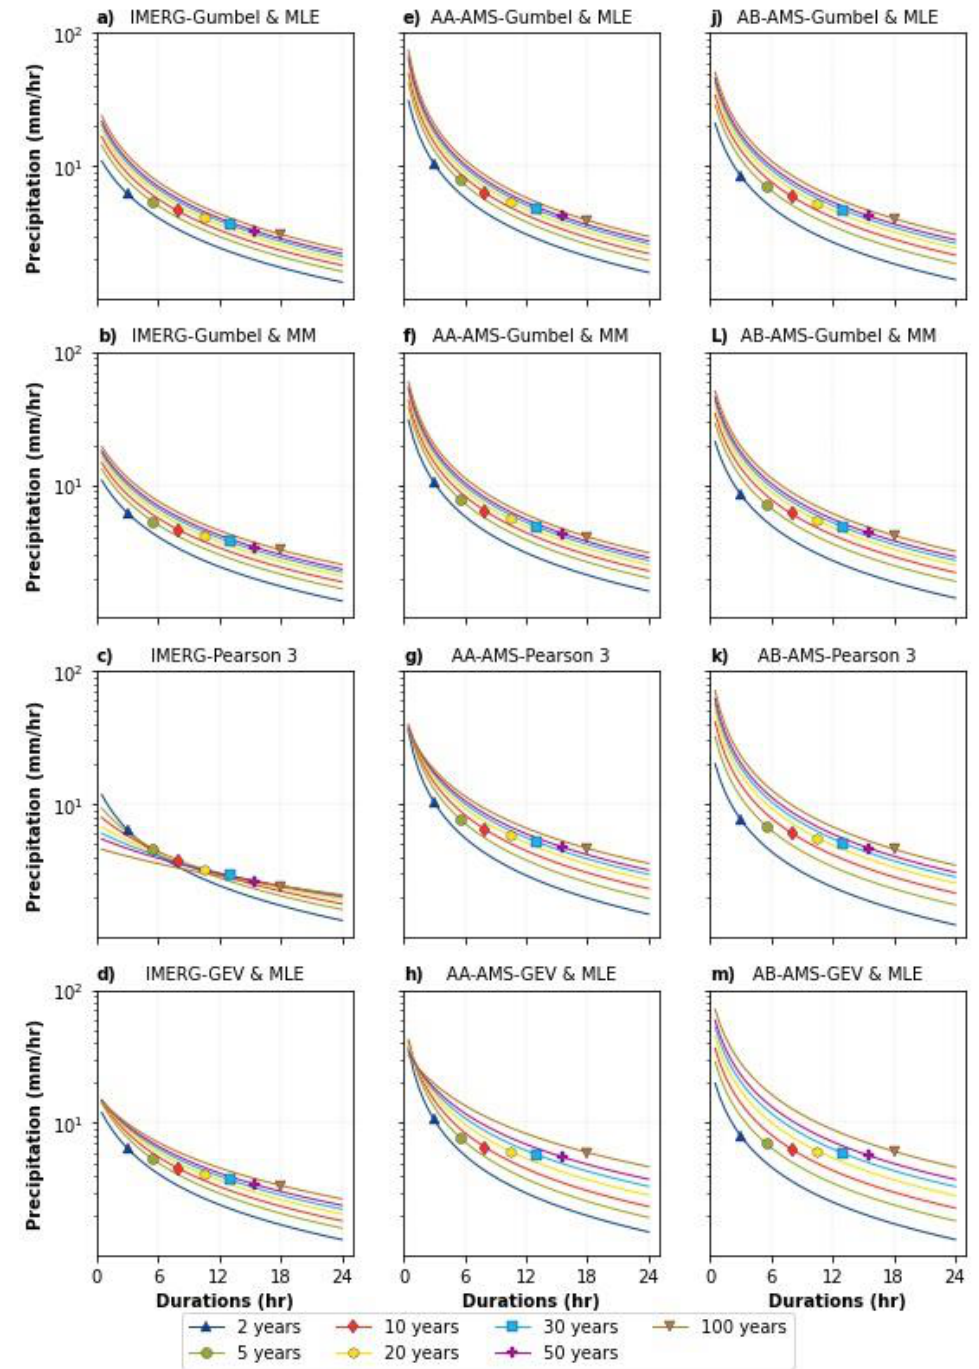
Figure A8. IDF curves fitted with the four CDFs over WGEW 1 for the 2, 5, 10, 20, 30, 50, and 100 year return periods and durations from half-hour to 24 h. From left to right : IMERG, AA-AMS, and AB-AMS. From top to bottom : Gumbel and MLE, Gumbel and MM, Pearson 3, and GEV and MLE. The marker’s purpose is only to distinguish the IDF curves.